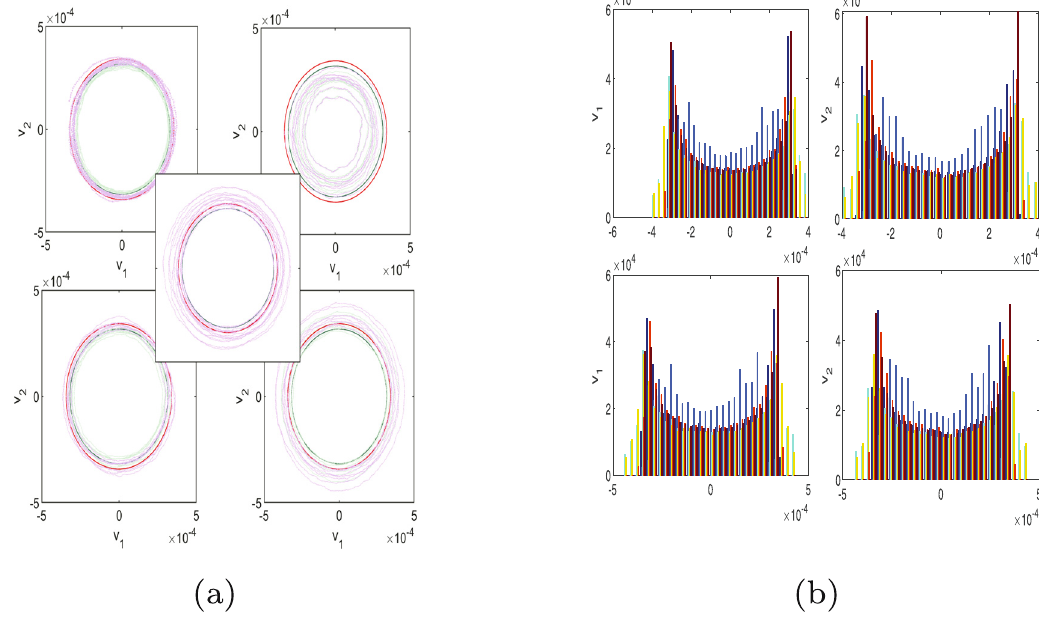
Figure 3: ( a ) The phase portraits and ( b ) hists for double limit